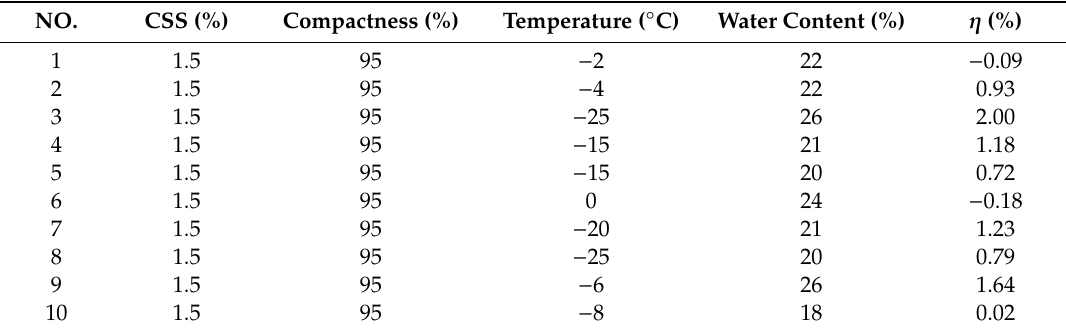
Table A1. All data of frost-heaving